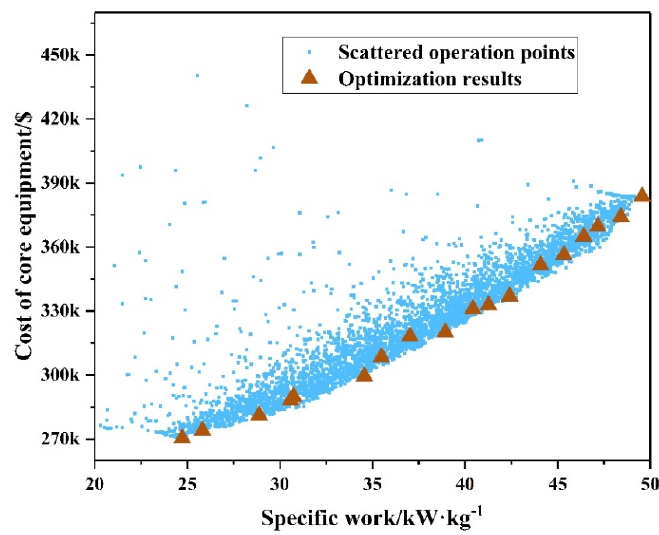
Figure 12. Optimization result of recompression cycle.